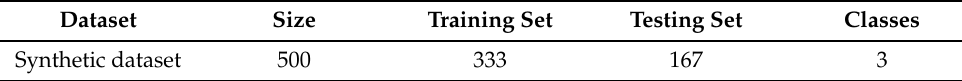
Table 1. The summary of Synthetic